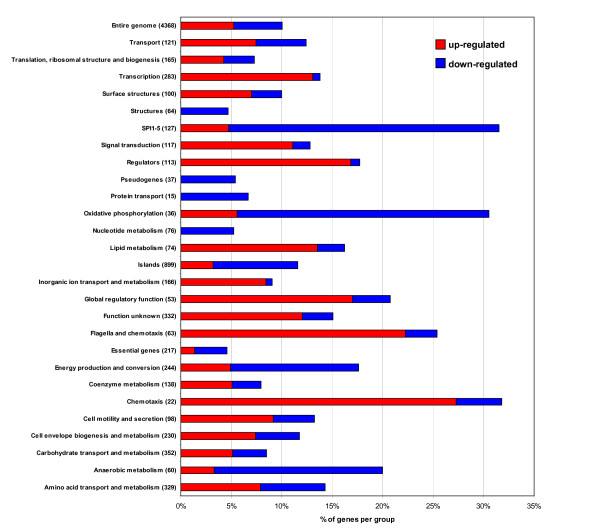
Whole genome expression profiling of S. Typhimurium SL1344 flowing biofilms compared to planktonic cells when grown in CFA at 25°C for 72 h. Expression changes of genes belonging to functional groups and pathogenicity islands (numbers in parenthesis refer to the genes assigned to each functional group from the genome of S. Typhimurium LT2). The bars show the percentage of genes belonging to each group that were altered for expression > 2-fold between planktonic and flowing biofilm cells. The blue bars indicate the proportion of genes that are down-regulated and the red bars represent the proportion of up-regulated genes for each group during biofilm growth (P < 0.01).